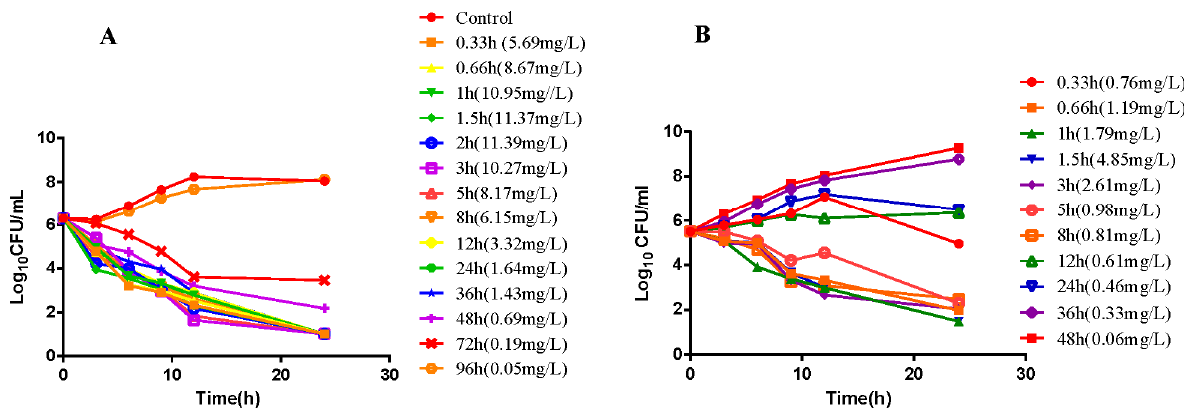
Figure 2. The ex vivo killing curve of CEF against HB13 in plasma ( A ) and BALF from infected pigs ( B ).